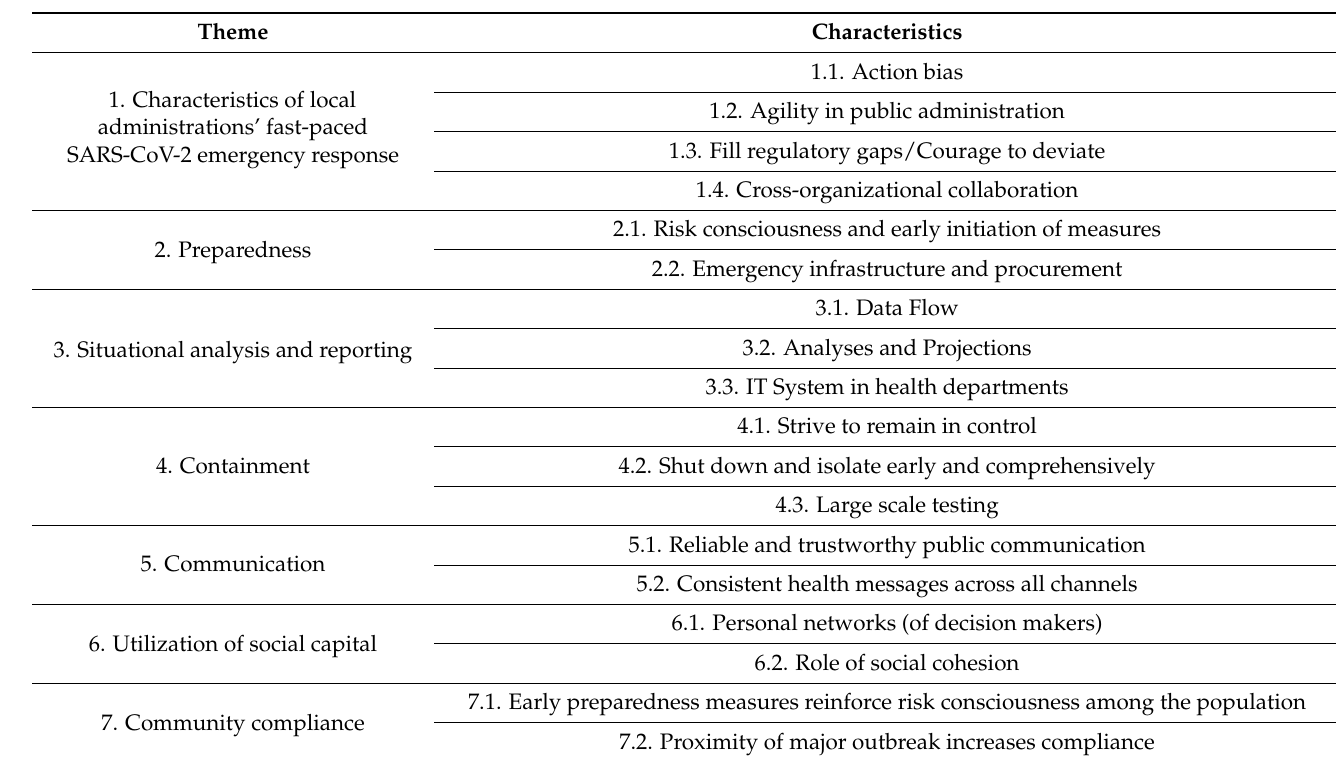
Table 4. Result summary of